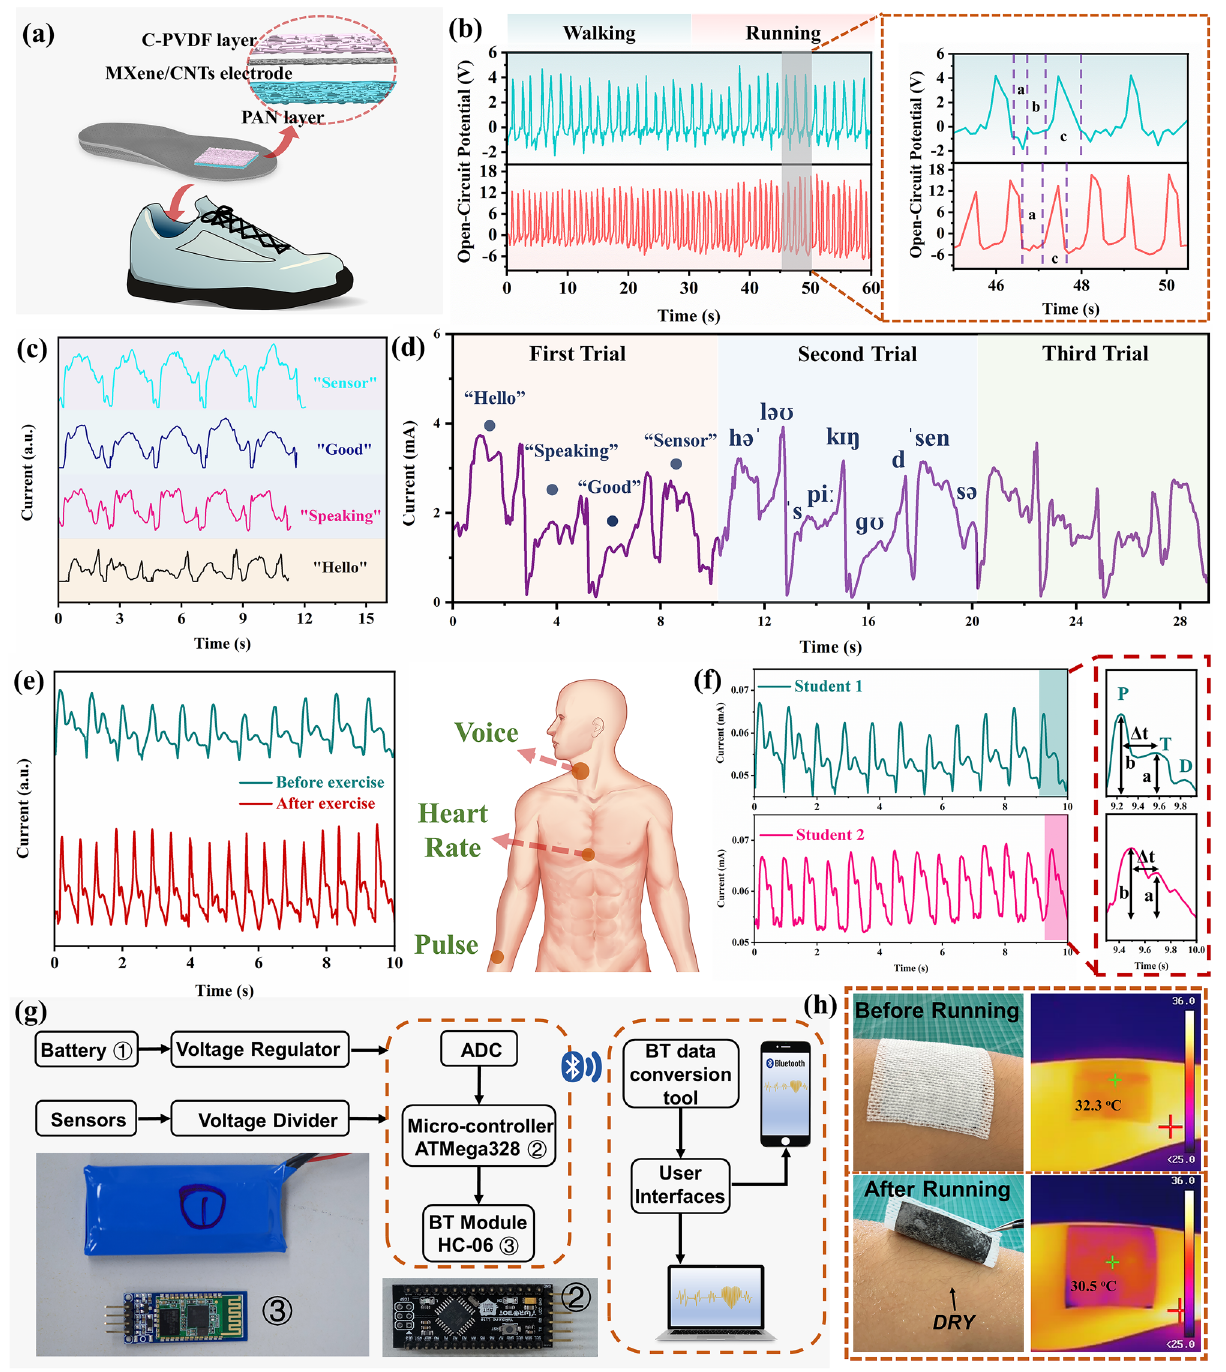
Fig. 6 DMWES for all-range health monitoring. a Gait sensing scheme of the DMWES. b The gait sensing signal and enlarged signal of the DMWES. c Voice signal of the different words. d Voice signal of the sentence of continuous words speaking. e Wrist pulse signal of a 28-year- old male man before and after exercise. f Wrist pulse signal of two students. g Schematic illustration of the signal acquisition and analysis system including signal acquisition, processing, wireless transmission, and mobile application. h Optical and Infrared camera images of the DMWES on skin before and after running